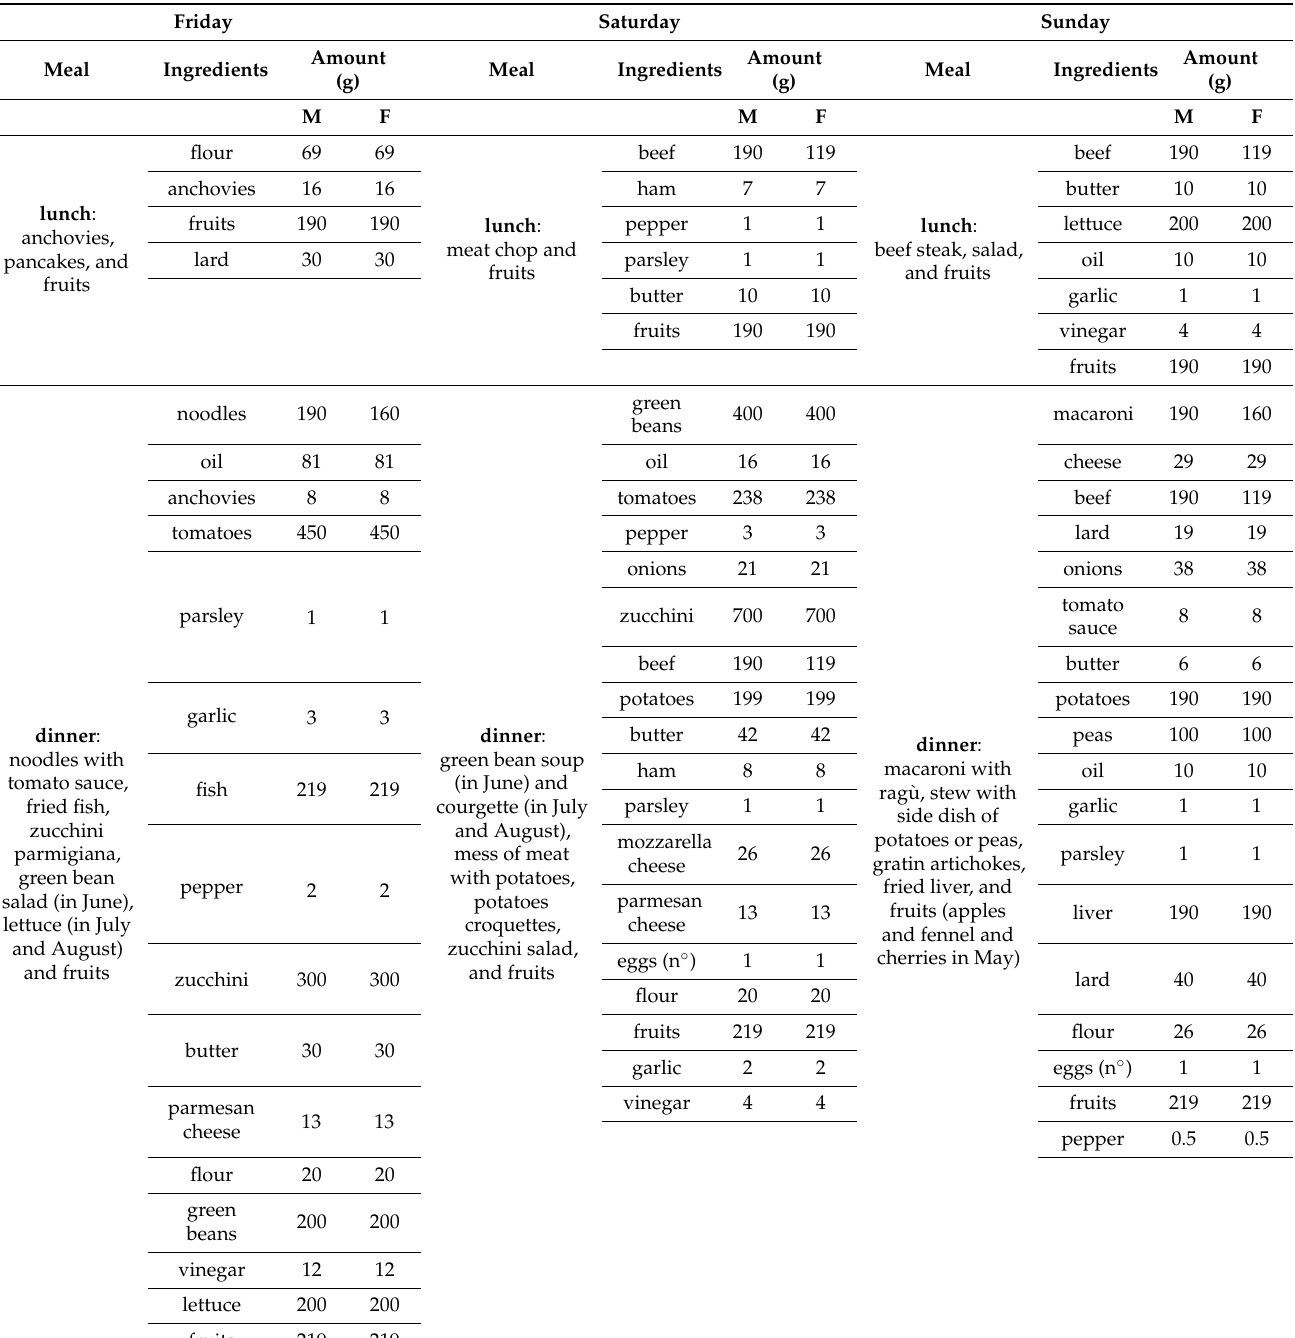
Table 8. Individual meals for 1st and 2nd class patients at lunch and dinner. Months: June, July and August (2)